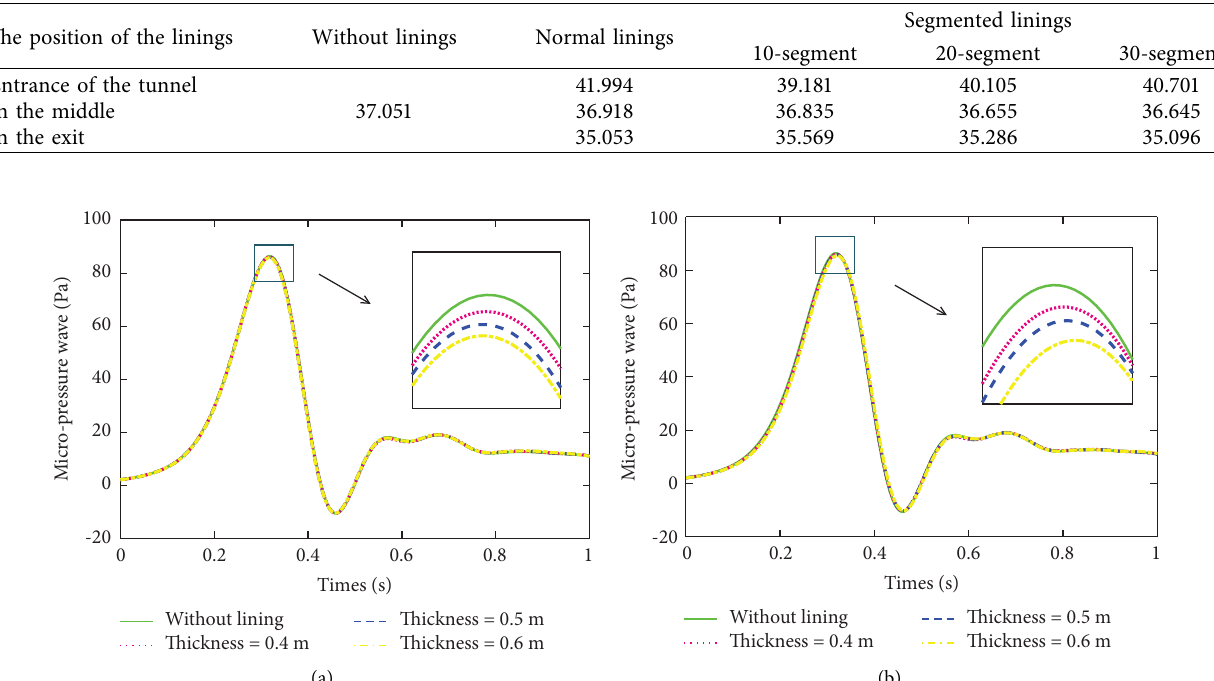
Table 5: Te amplitude values of the micro-pressure wave at M 3.